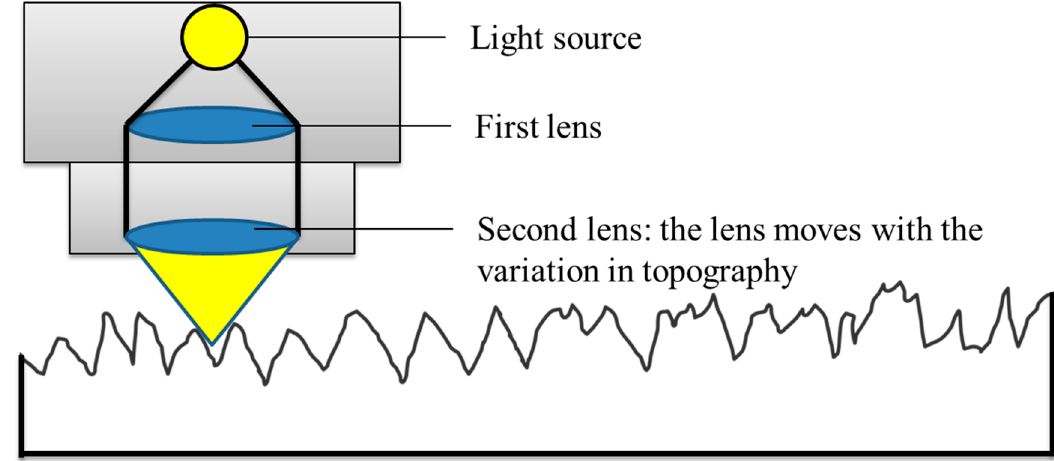
Figure 1. Schematics of mechanical test specimens: ( a ) Tensile; ( b ) Three point bend; ( c ) Charpy impact toughness; ( d ) Fracture toughness test specimens.